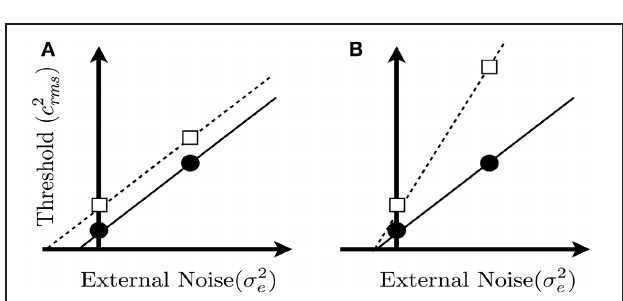
FIGURE 2 | Hypothetical noise masking functions predicted from Equation 1. Each panel shows two noise masking functions for two groups, in which threshold is plotted as a function of the variance of the external noise mask. The two functions in each panel could represent thresholds measured from two groups of subjects, or under two different viewing conditions. The external noise is zero at the point where the x and y axes intersect. Panel (A) shows two masking functions that differ only in terms of equivalent input noise (i.e., parameter σ 2 i in Equation 1). Panel (B) shows two masking functions that differ only in terms of calculation efficiency, which is related to the reciprocal of parameter k in Equation 1. Note that thresholds in the zero noise conditions, represented by the square and circle, are the same in the two panels. Hence, a threshold difference measured in the no-noise condition could be produced by a change in internal noise or calculation efficiency (or a combination of both